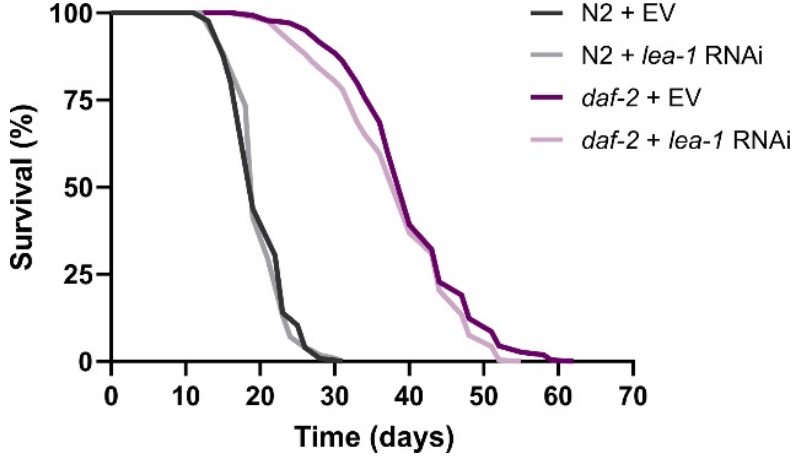
Figure 5. Survival curves of wild-type N2 and daf-2(e1370) worms subjected to lea-1 RNAi. The graph represents pooled data from two independent experiments. EV—empty vector control. The data are summarized in Table S1.